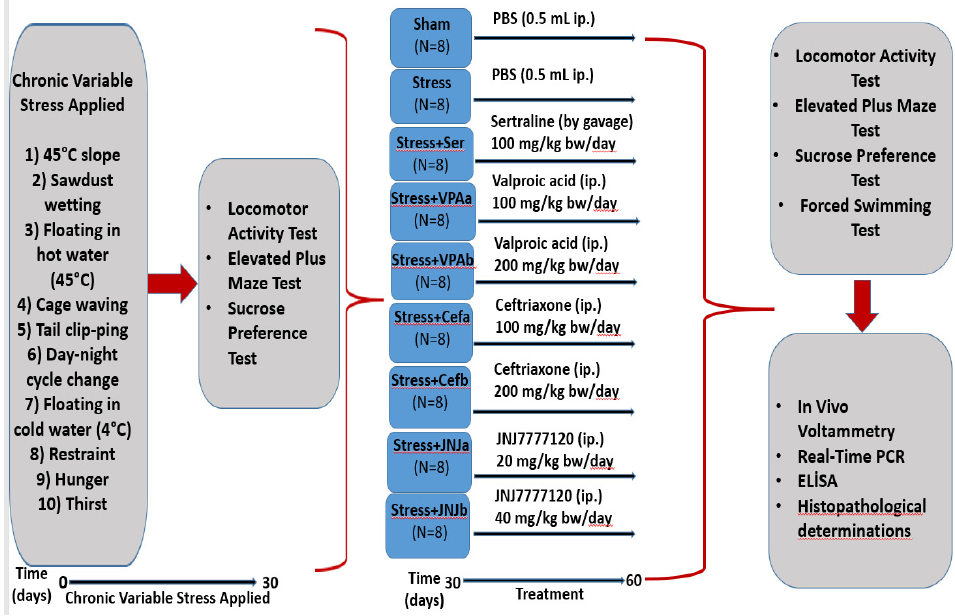
Figure 1. Flow chart of the study. Schedule of the experimental procedures. The experiment has two steps. The mild stress model was established between 0–30 days. The treatment starts from day 30–60. Different analyses were done on the 30th day and the 60th day.